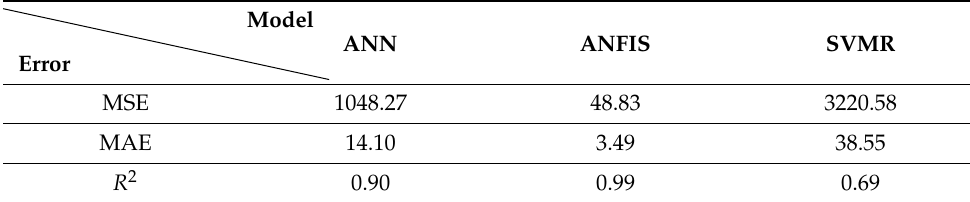
Table 8. The performance results for constructed models.